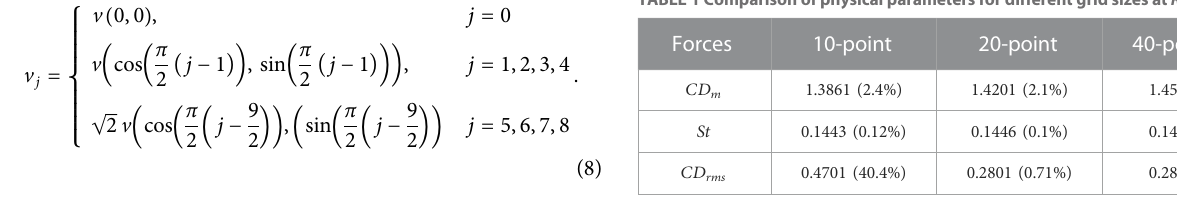
TABLE1Comparisonofphysicalparametersfordifferentgridsizesat Re